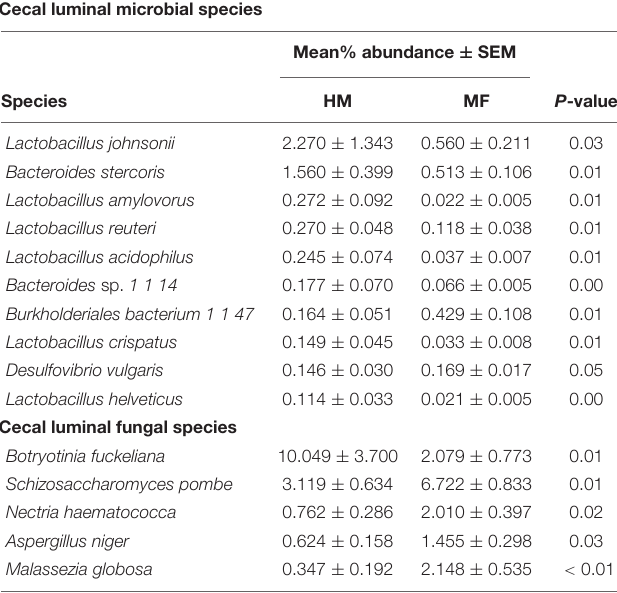
P-values were determined by Mann–Whitney